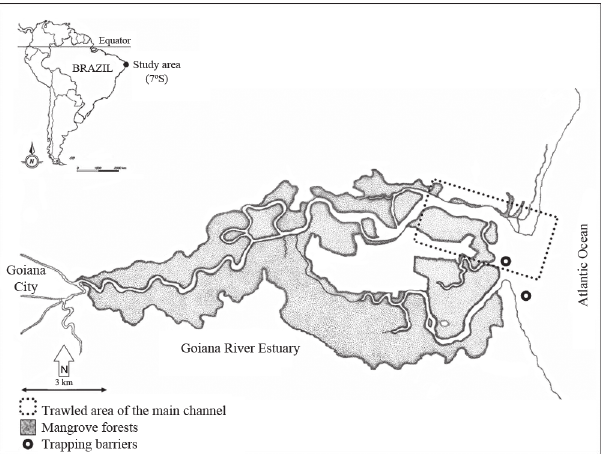
Fig. 1. Location and details of the study area, Goiana Estuary at the Brazilian